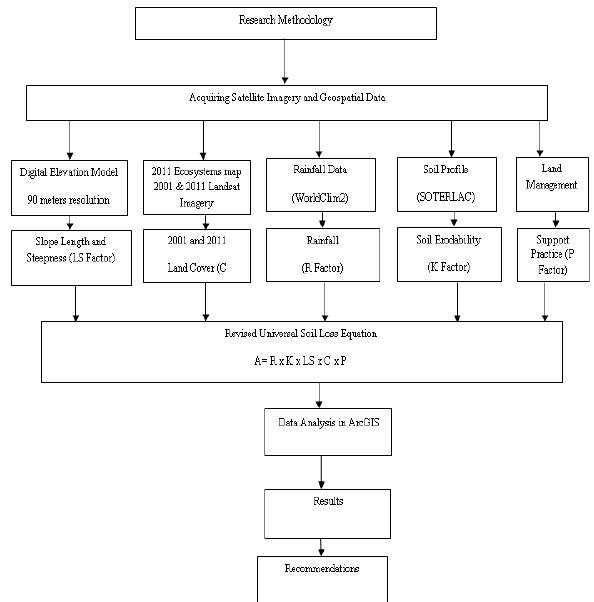
Figure 2. Flow diagram depicts the preparation and analysis of geospatial data to identify susceptible areas to erosion and estimate soil erosion in the Rio Grande